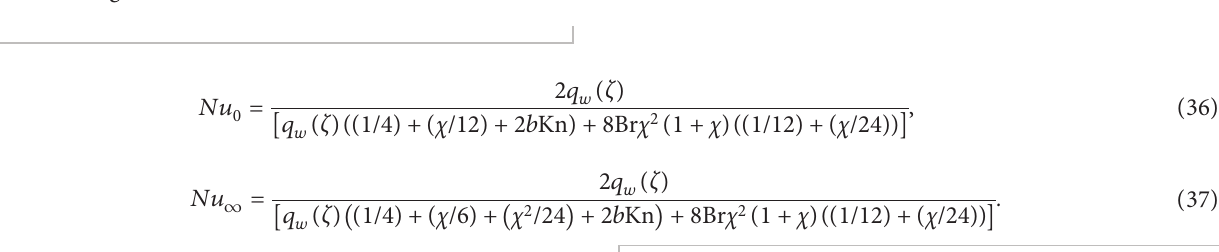
Figure 4: Comparison between numerical (blue dots) and analytical results (red continuous lines) for the constant wall heat flux q Br � 0 . 1, Kn � 0 . 0, α � 0 . 02, β − � β + � 1. (a) θ b versus ζ for Pe � 10 0 , 10 1 , 10 2 , 10 3 , 10 4 , 10 5 ; (b) θ w versus ζ for Pe � 10 − 2 , 10 − 1 , 10 0 , 10 1 , 10 2 , 10 3 . The arrows indicate increasing values of